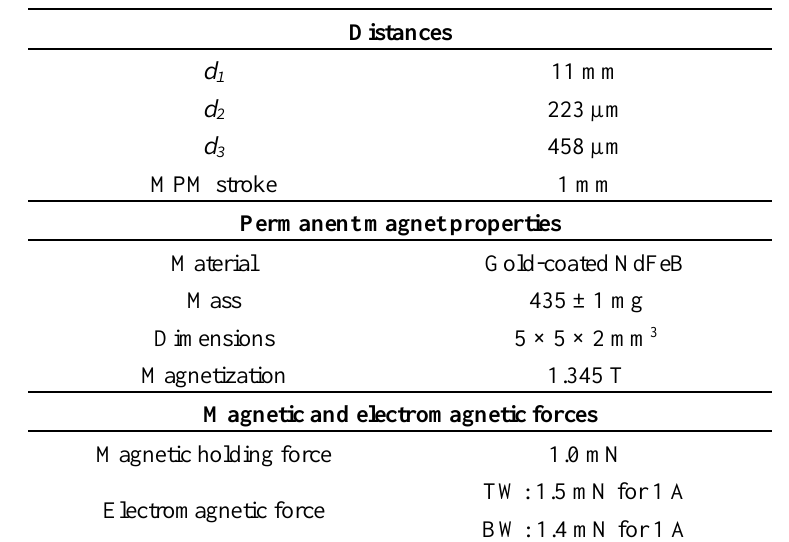
Table 1. Actuator